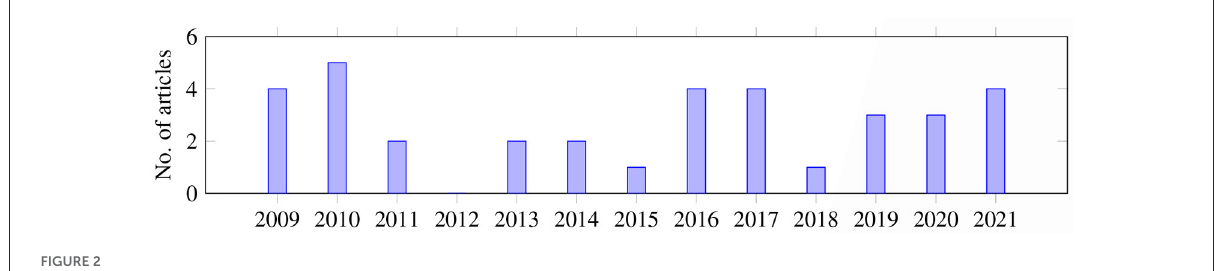
FIGURE2 Number of publications by year.